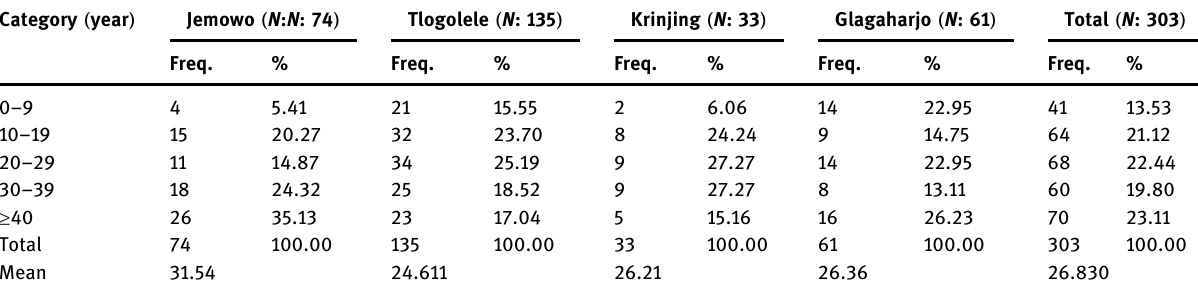
Table 8: Farming experience of the respondents Category ( year )